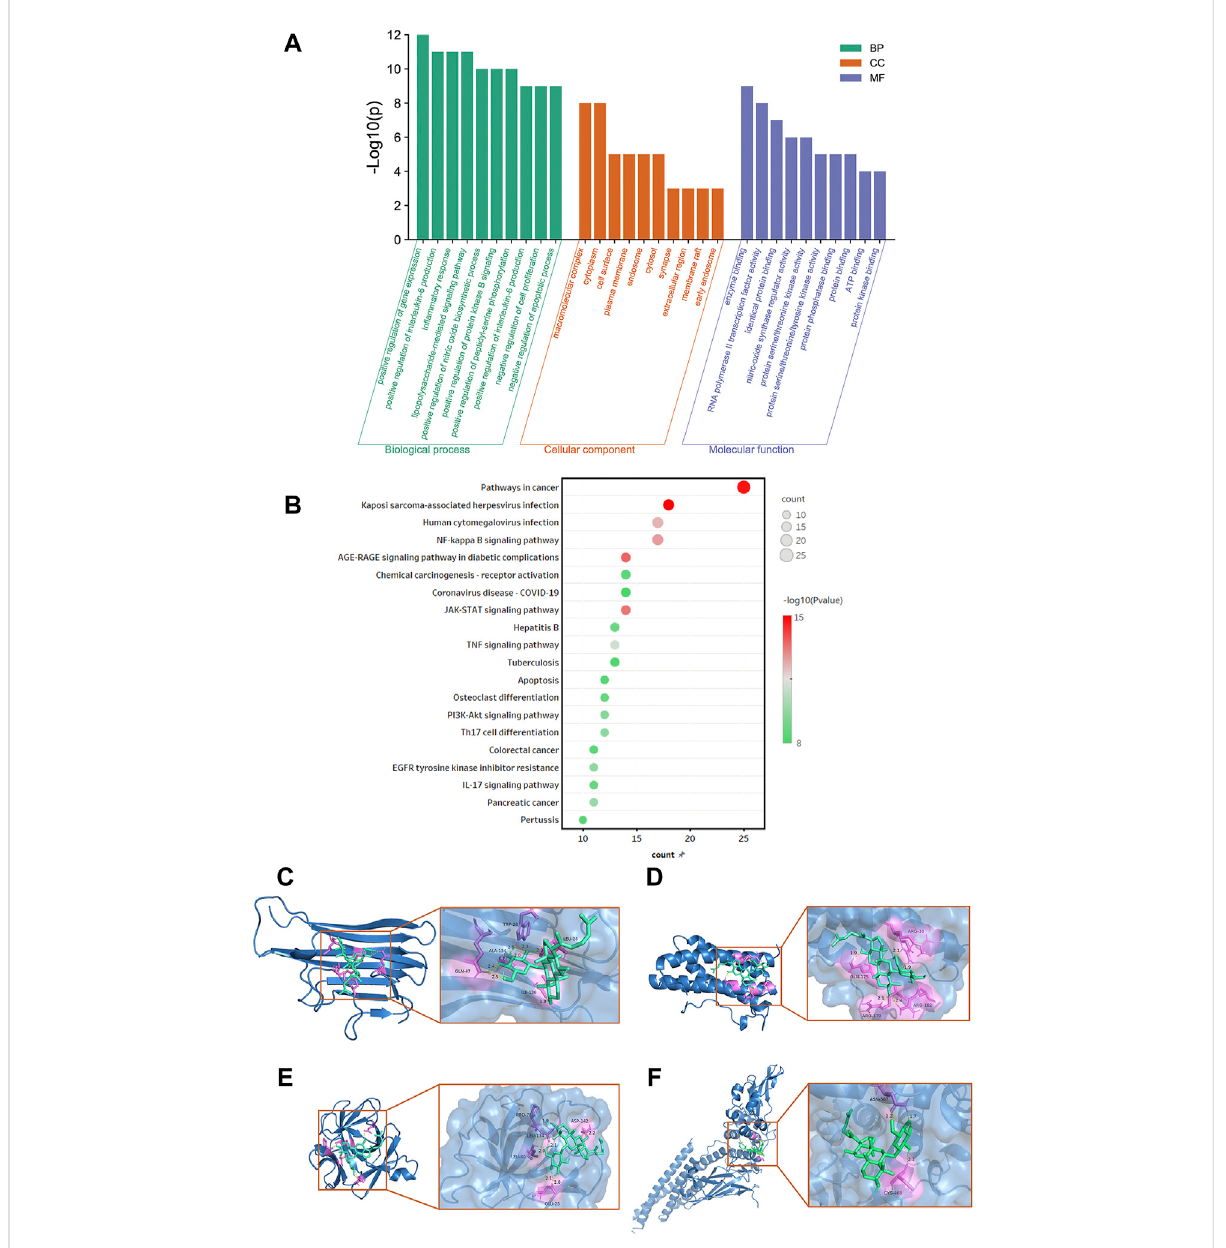
FIGURE 3 Functional enrichment analysis and docking simulation. Gene Ontology (A) and KEGG pathway enrichment (B) analysis of the target genes of G-Rh4 against in fl ammation. (C – F) The docking mode of G-Rh4 binding with target proteins; (C) TNF- α , (D) IL-6, (E) IL-1 β , and (F)